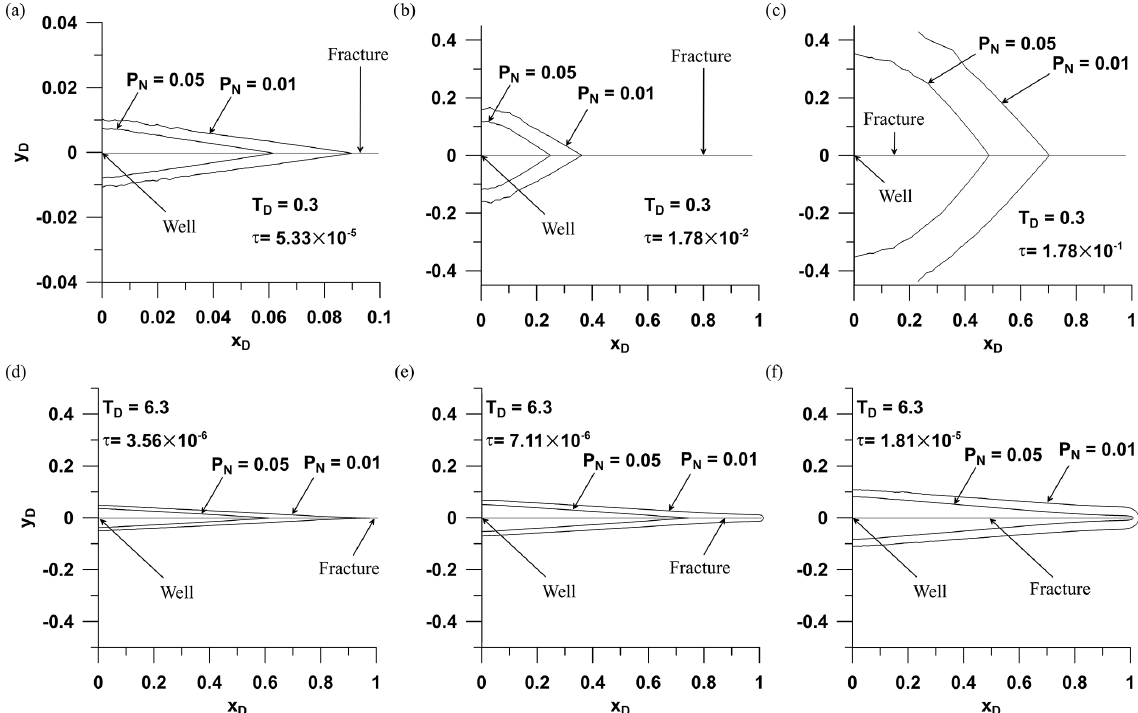
Figure 3. Spatial evolution of isobars P N = 0 . 01 and P N = 0 . 05 over time through the modeling domain, for the dimensionless fracture conductivities T D = 0 . 3 (a, b, c) and T D = 6 . 3 (d, e, f) . Note that for the case of T D = 0 . 3, the scale of the graph (a) is different from that used for the graphs (b) and (c) . Read text in Sect. 3.1 for a more detailed description of the